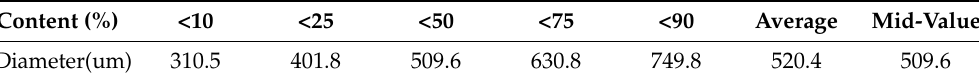
Figure 1. Diagram of physical experiment device. Table 1. Result of particle size analysis.